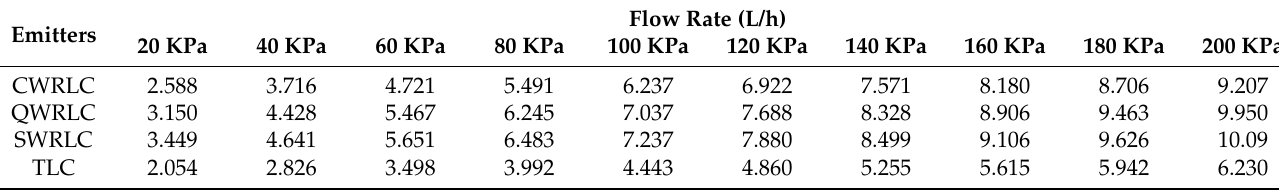
Table 3. Test flow rate statistics of the four emitters.